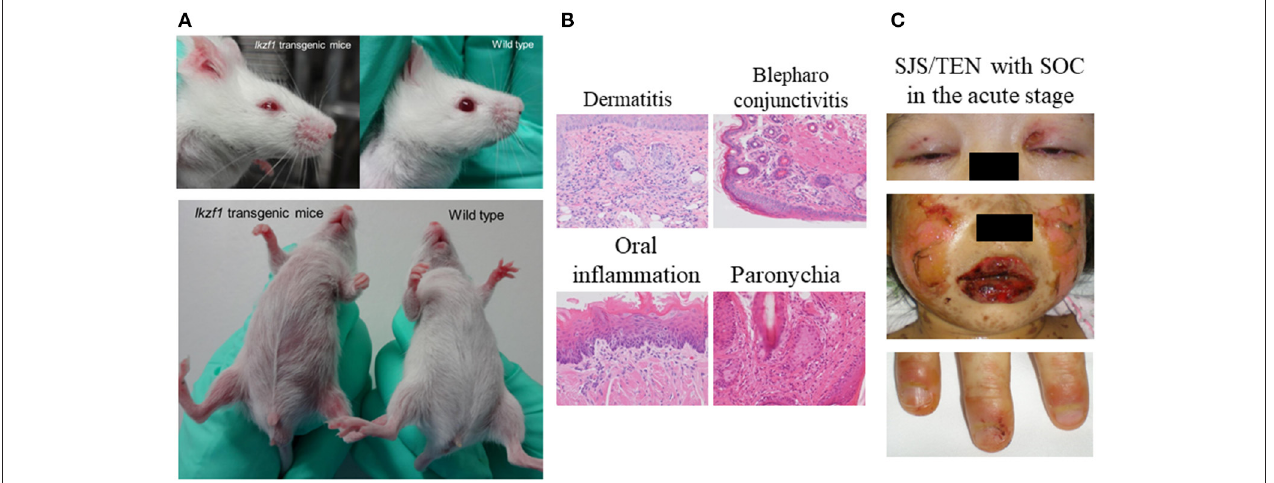
FIGURE 1 | Finding of K5- Ikzf1 -EGFP transgenic mice ( Ikzf1 Tg). Ikzf1 Tg mice were introduced the Ik1 isoform into cells expressing keratin 5, which is expressed in epithelial tissues such as the epidermis and conjunctiva. Ikzf1 Tg mice developed dermatitis and some developed blepharoconjunctivitis (A) . Histological analysis showed not only dermatitis but also tissue inflammation of their tongues, blepharoconjunctiva, and paronychia (B) as did patients with SJS/TEN with SOC in the acute stage of the disease (C) . Reprinted with permission from Ueta et al. (10, 28).